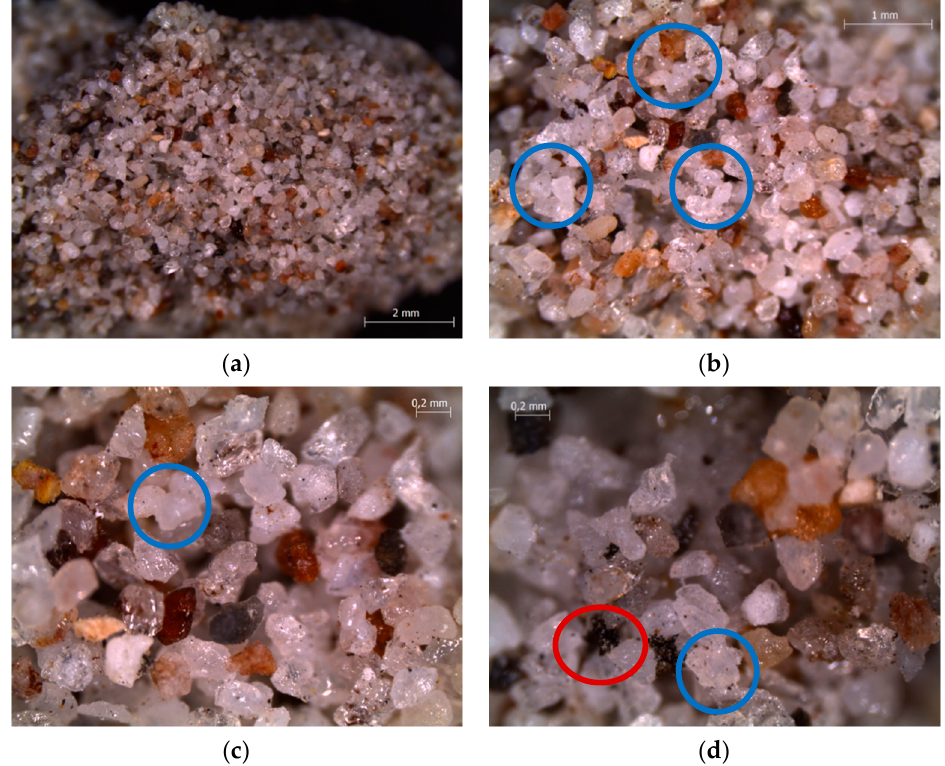
Figure 8. Stereo-microscope images of agglomerates from the spent sand bed after the last test, magnified at: 1× ( a ); 2× ( b ); 4× ( c ); 4× ( d ).